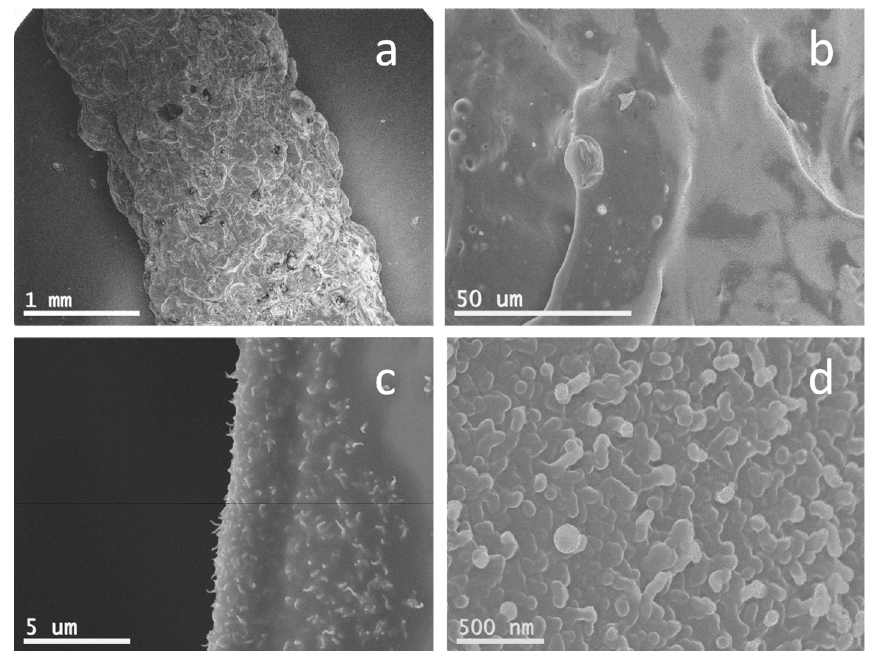
Figure 2. SEM images taken at 10kV of the carbonized stick surface. A sequence of SEM images, taken at increasing magnifications, showing the structures found on the burnt Sample 1a. In ( a ) we observed the full width of the stick; in ( b ) lighter patches, which contained nanostructures; ( c ) showed protruding nanostructures where the surface plane was “edge-on” to the beam; and in ( d ) a nanostructure “forest” observed in standard plan view.